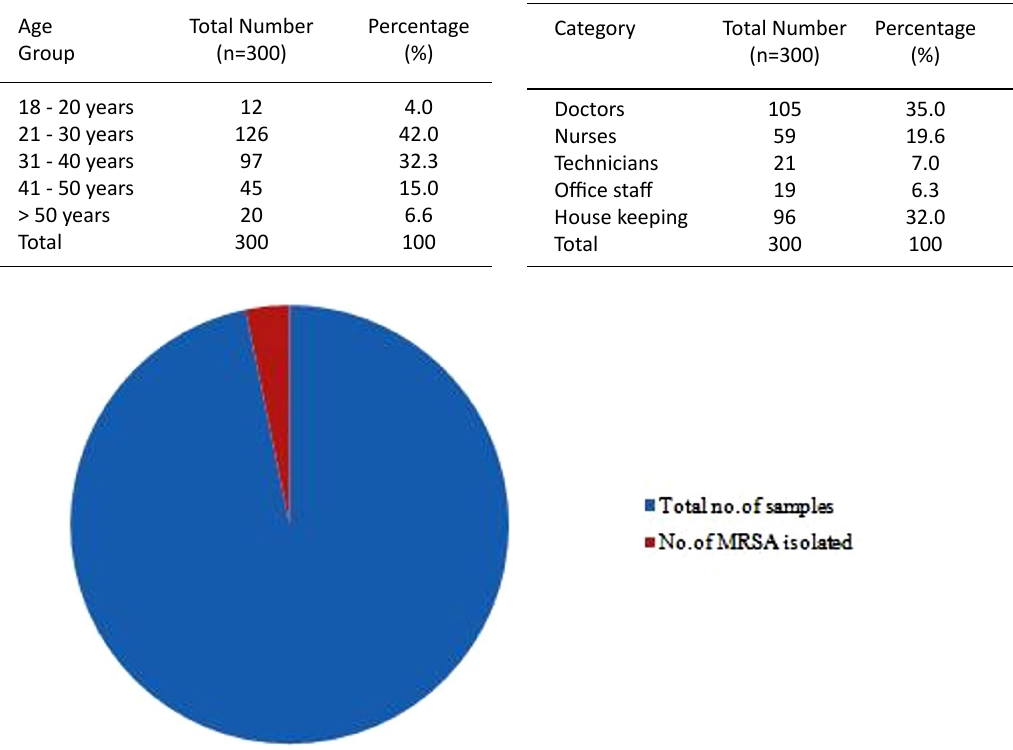
Fig. 1. Overall isolation rate of